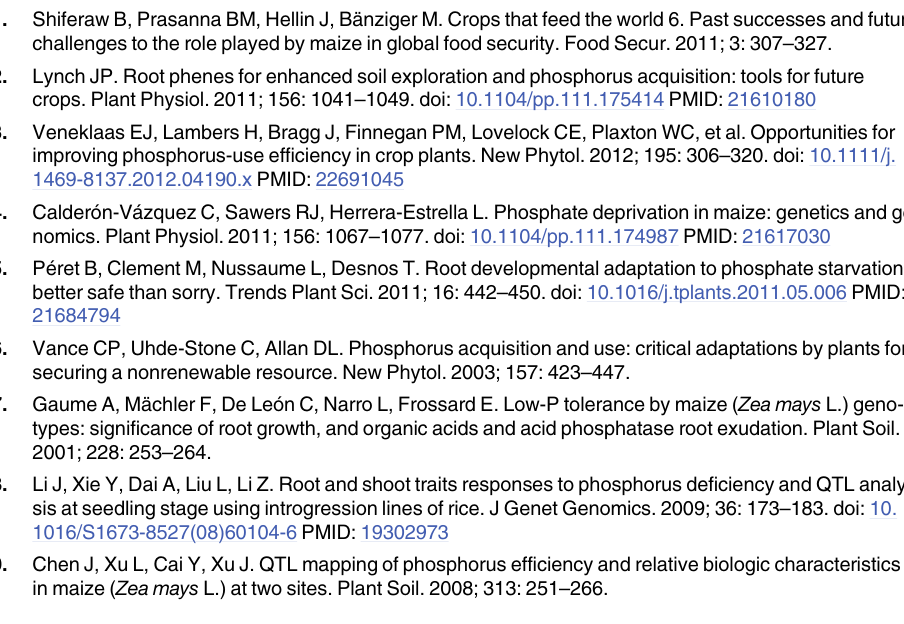
S2 Table. Correlation between LPTIs and the relative trait values that were used to calculate the corresponding LPTIs. Notes: LPTIs refer to LPTI, LPTI_bm, LPTI_lf, LPTI_el, and LPTI_lt; Correlation coefficients > 0.07, 0.09 and 0.11 were significant at 0.05, 0.01 and 0.001 level, respectively; a. Correlation coefficients between LPTI and the relative trait value for each trait; b. Correlation coefficients between LPTI_bm and the relative trait value for biomass traits (shaded), and between LPTI_lf and the relative trait value for leaf number traits (underlined); c. Correlation coefficients between LPTI_el and the relative trait value for early-stage traits (in bold), and between LPTI_lt and the relative trait value for later-stage traits (in italics). S3 Table. Selection of extreme lines based on multiple criteria. Notes: Selection based LPTI (a), LPTI_bm (b), LPTI_lf (c), LPTI_el (d) and LPTI_lt (e); common-1: number of the maize accessions shared by selections based on LPTI_bm and LPTI_lf; common-2: number of the maize accessions shared by selections based on LPTI_el and